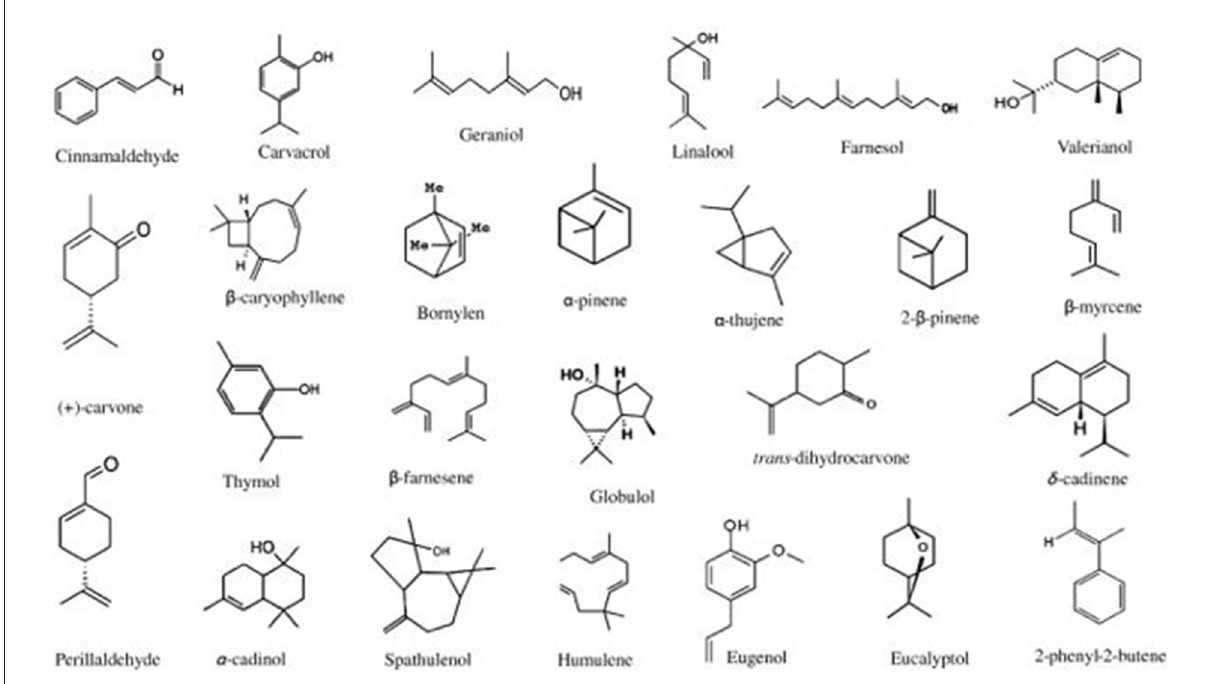
FIGURE1 Chemical structures of components of essential oils [adopted from Bajpai et al. (88)].